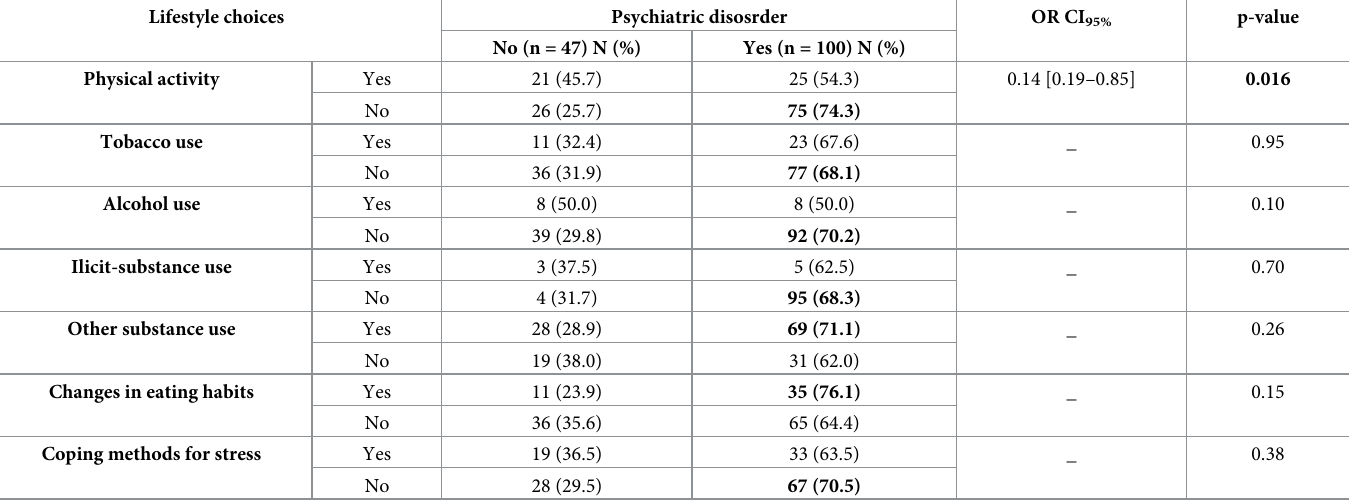
Table 4. Lifestyle choices associated with mental health in medical students, Sousse, Tunisia, 2021.